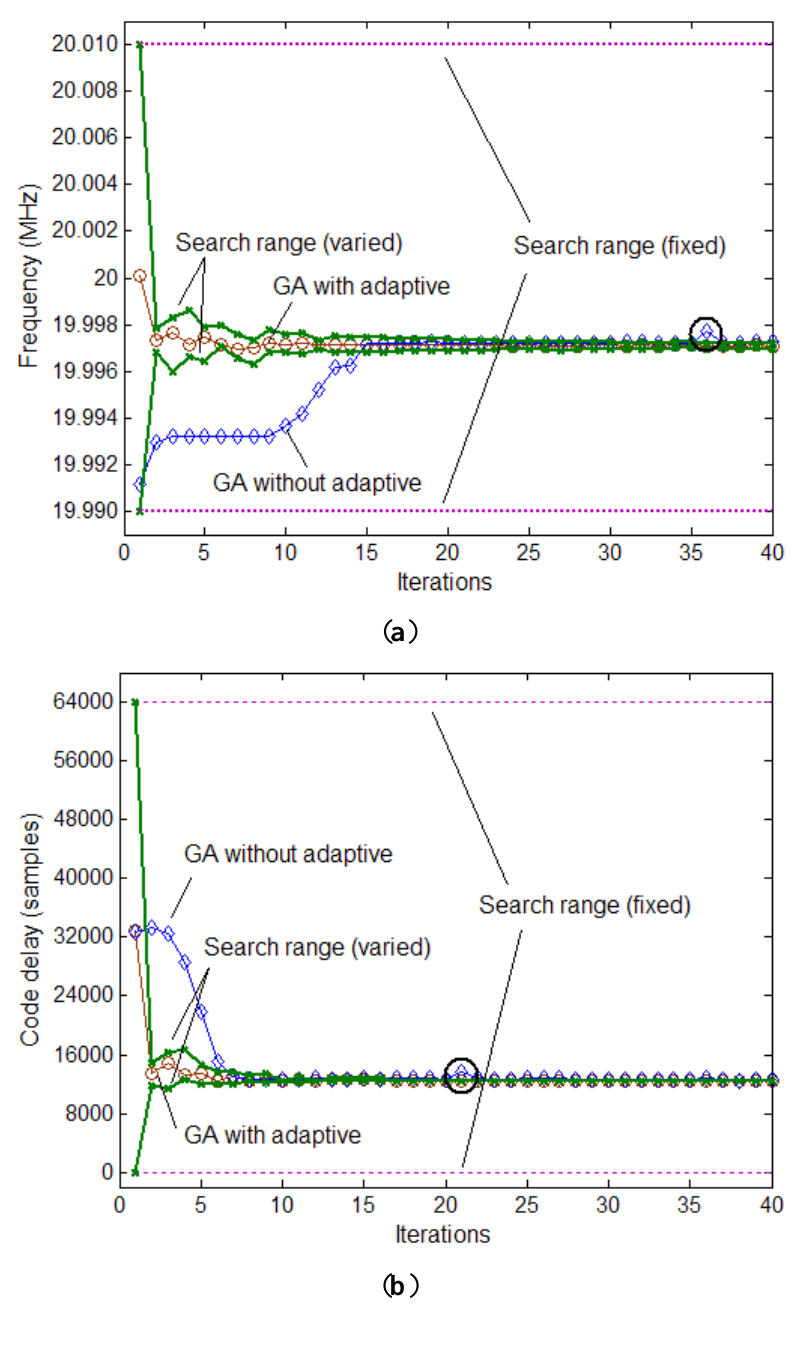
Figure 3. Evolution curve of signal acquisition for C/A-code; ( a ) Doppler frequency; ( b ) code